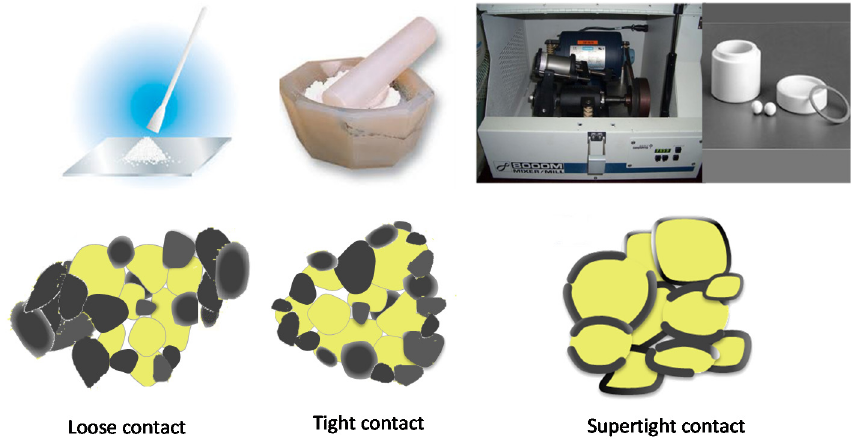
Scheme 1. Different kinds of contact obtained by mixing soot (black) and catalyst (yellow) using a spatula, an agate mortar and a high-energy mill.